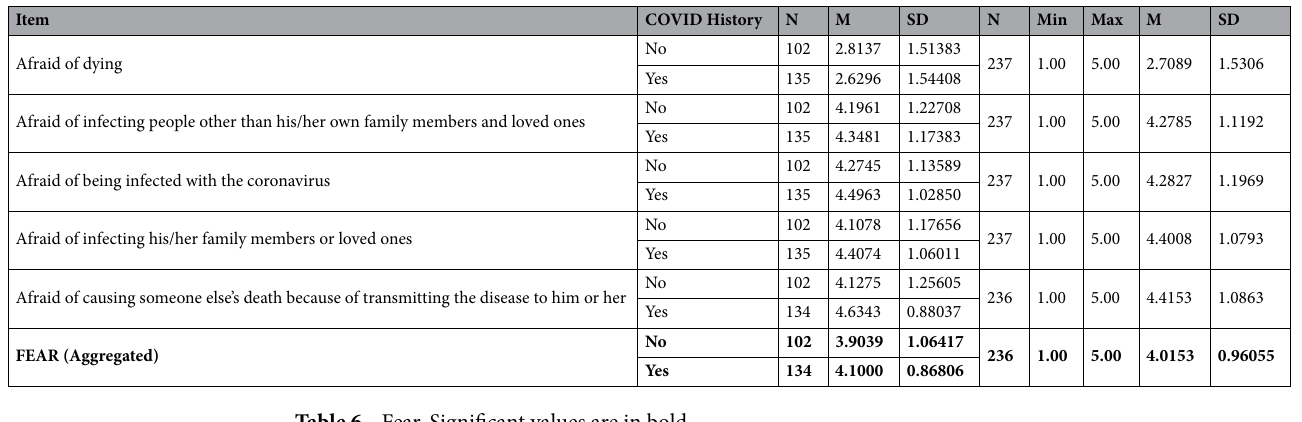
Table 6. Fear. Significant values are in